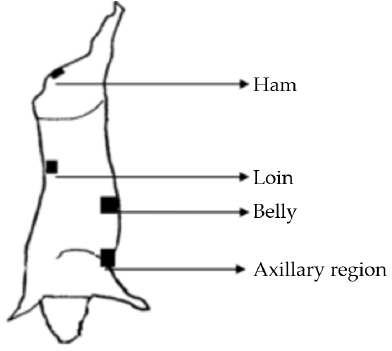
Figure 1. Pig carcass sampling sites.